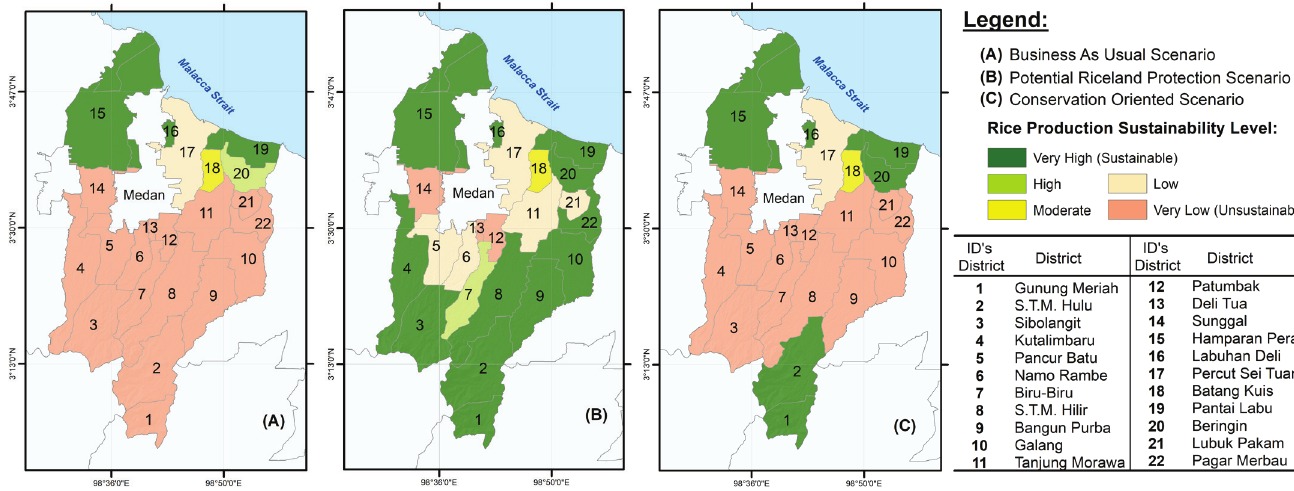
Figure 7. Rice production sustainability map at BAU (A), PRP (B) and CO (C) scenario by 2040.